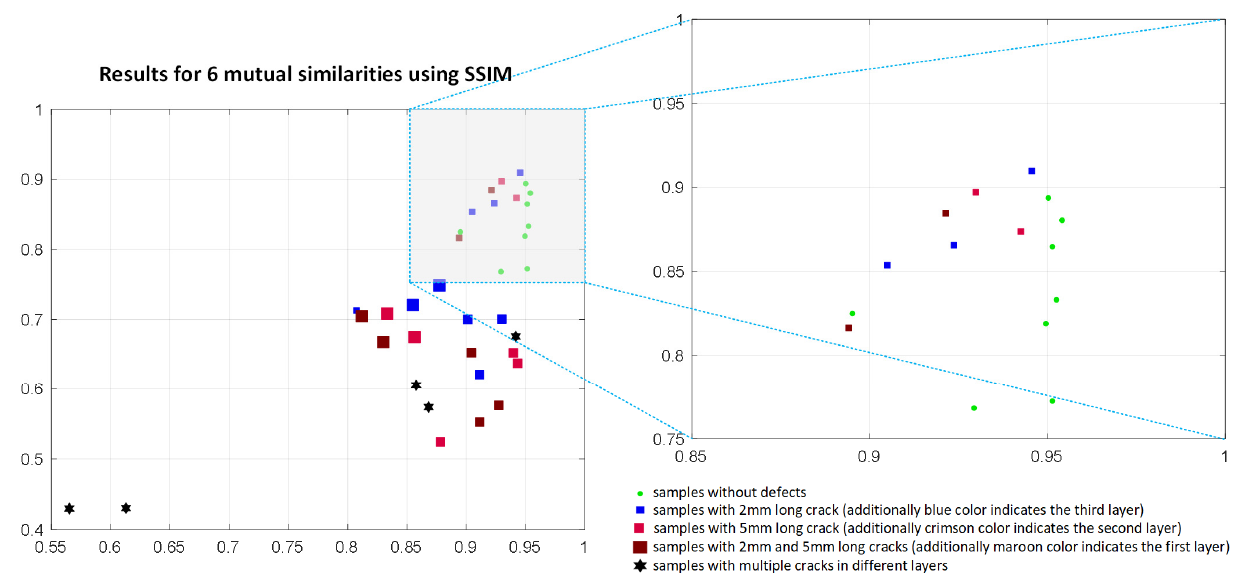
Figure 19. Results obtained applying six mutual comparisons employing the SSIM metric using the maximum and average of its values calculated for 17 images corresponding to various frequencies used in experiments.